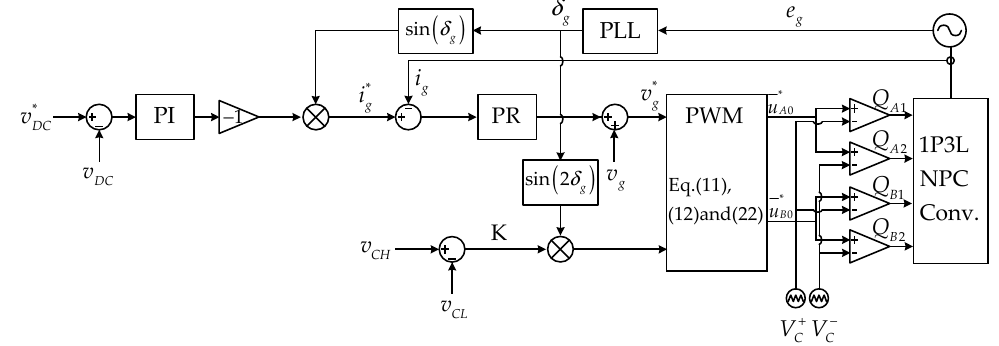
Figure 6. Control block diagram for capacitor voltage balance.